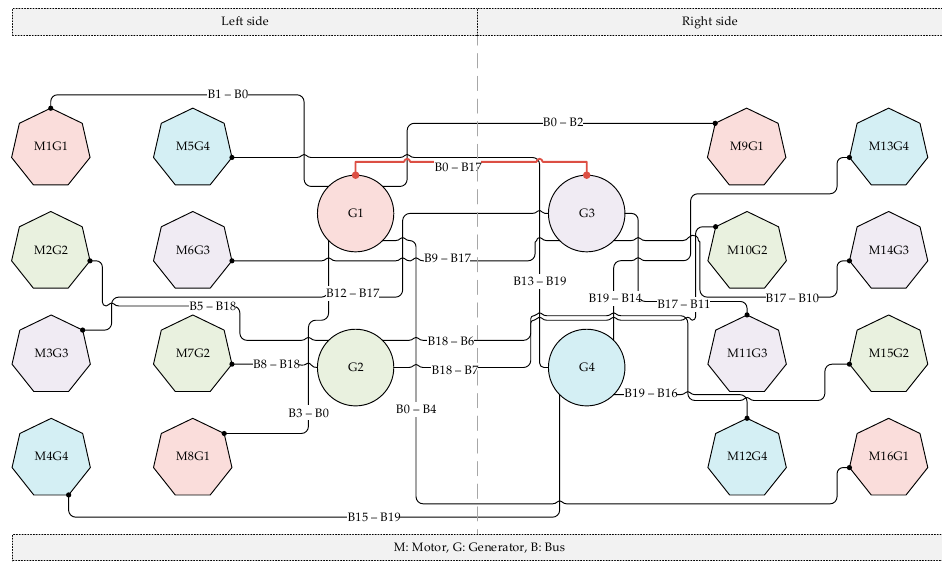
Figure 7. NASA N3-X schematic system model.